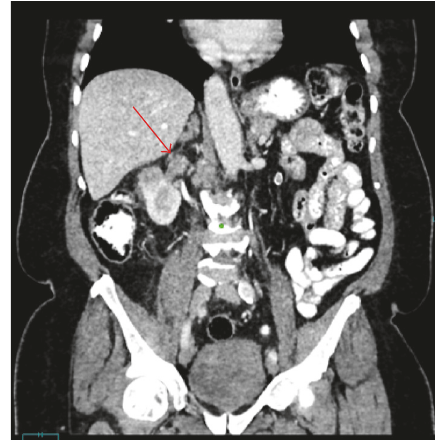
Figure 2: Contrast enhanced computed tomography coronal image demonstrates tumoural thrombus within the right renal vein (red arrow).